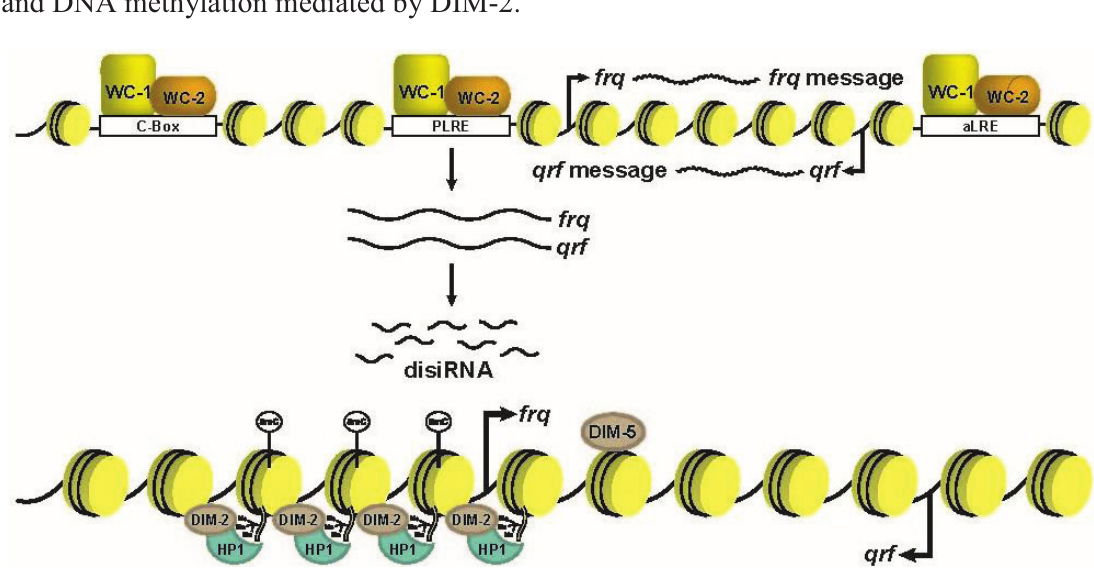
Figure 4. DNA methylation at the frq . The molecular mechanism of de novo DNA methylation in Neurospora at frq . The sense antisense pair gives rise to disiRNA that promote H3K9me3. Once the H3K9me3 is established, there is subsequent binding of HP1 and DNA methylation mediated by